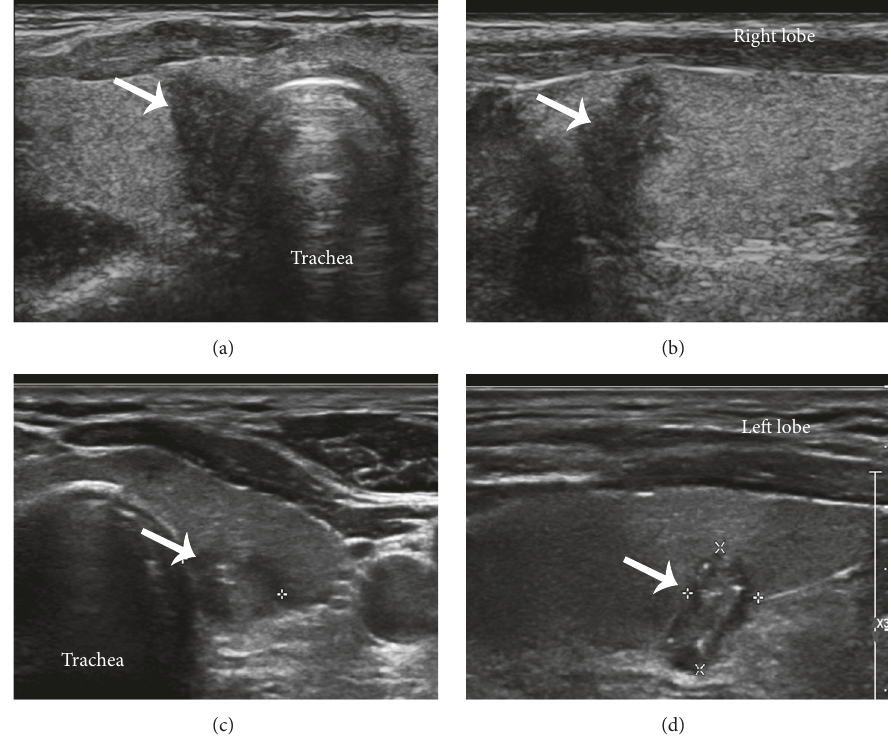
Figure 2: (a) Transverse and (b) longitudinal images showing a thyroid microcarcinoma (arrow) located medial to the trachea and (c) transverse and (d) longitudinal images showing a thyroid microcarcinoma located posterior to the dorsal thyroid